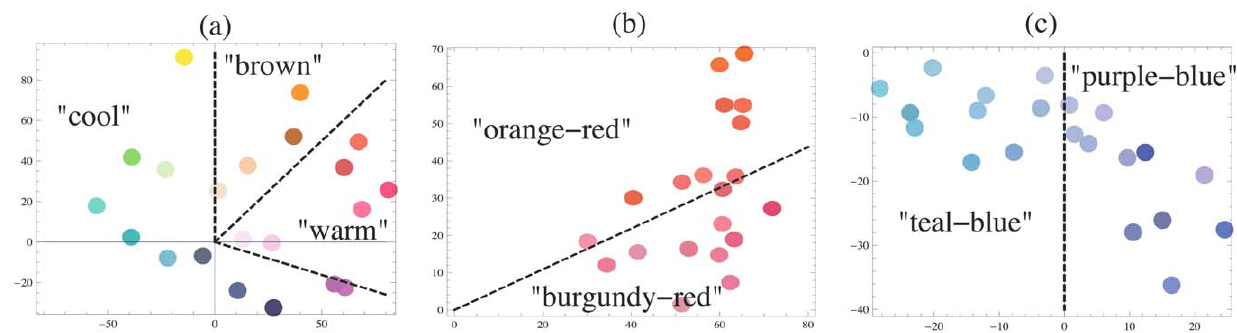
Figure 2. Optimal category choices in the three experimental conditions, global (a), red (b) and blue (c). The 21 stimuli in each condition are plotted on the a*b* plane (please note the scale difference among the three conditions). The color stimuli are presented by colored dots that approximate the colors of the stimuli. The categories are separated by radial dashed lines.